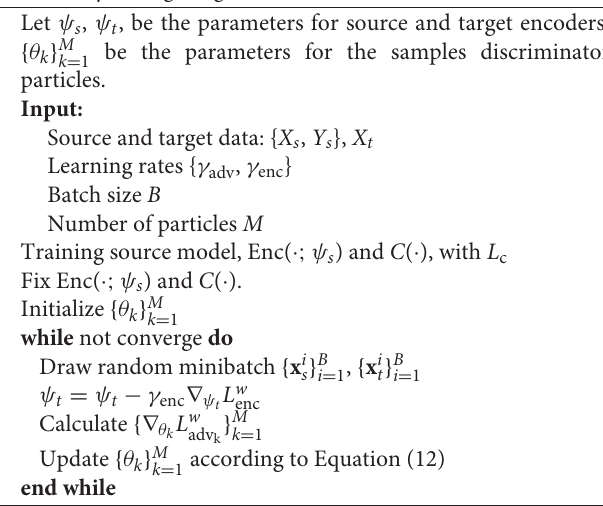
Algorithm 1 Adversarial domain matching with Wasserstein uncertainty reweighting.